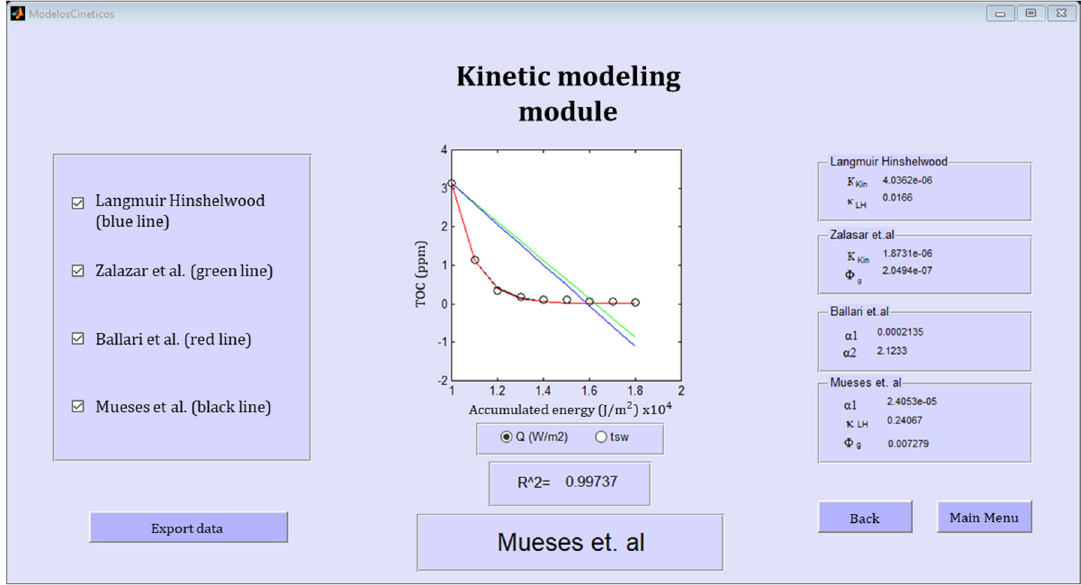
Figure 8. Methylene blue solar photodegradation fitting in an offset multi-tubular photoreactor (OMTP) for the four available kinetics models in the kinetic modeling module.